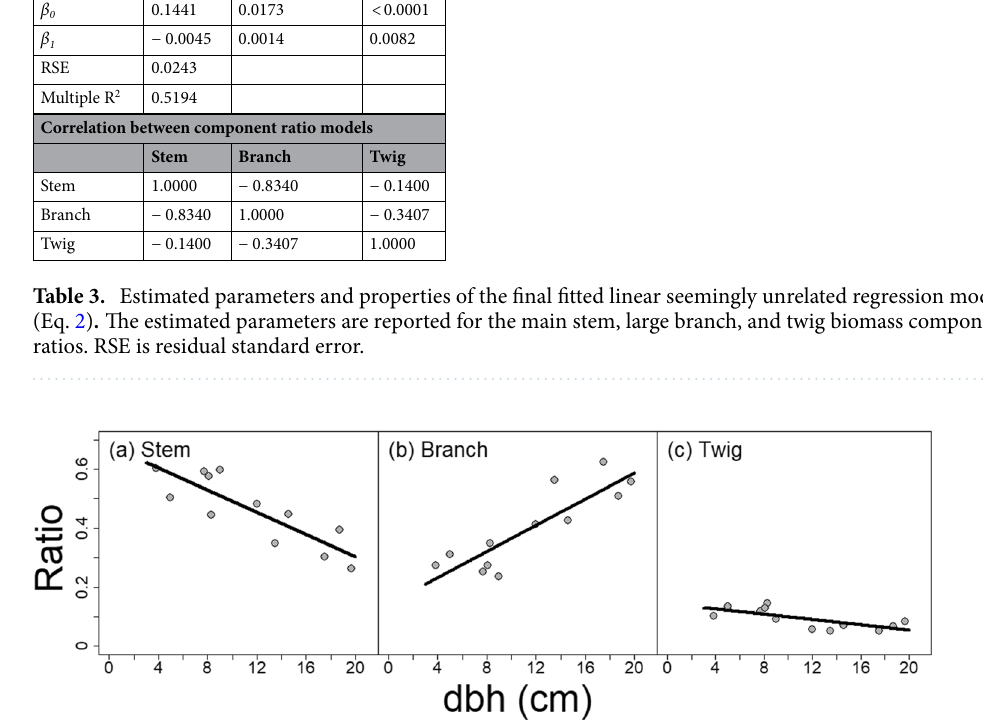
Figure 3. Final fitted Linear Seemingly Unrelated Regression models (Eq. 2) of the component ratios over dbh. The biomass component ratios are: (a) main stem, (b) large branch, and (c) twig. Black solid lines depict fitted regression models. Gray circles depict observed